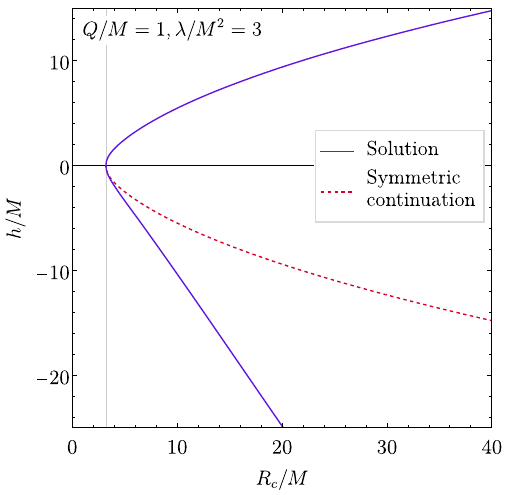
Fig. 21 Embedding diagram of wormhole a solutions for parameters Q / M = 1 and λ/ M 2 = 3